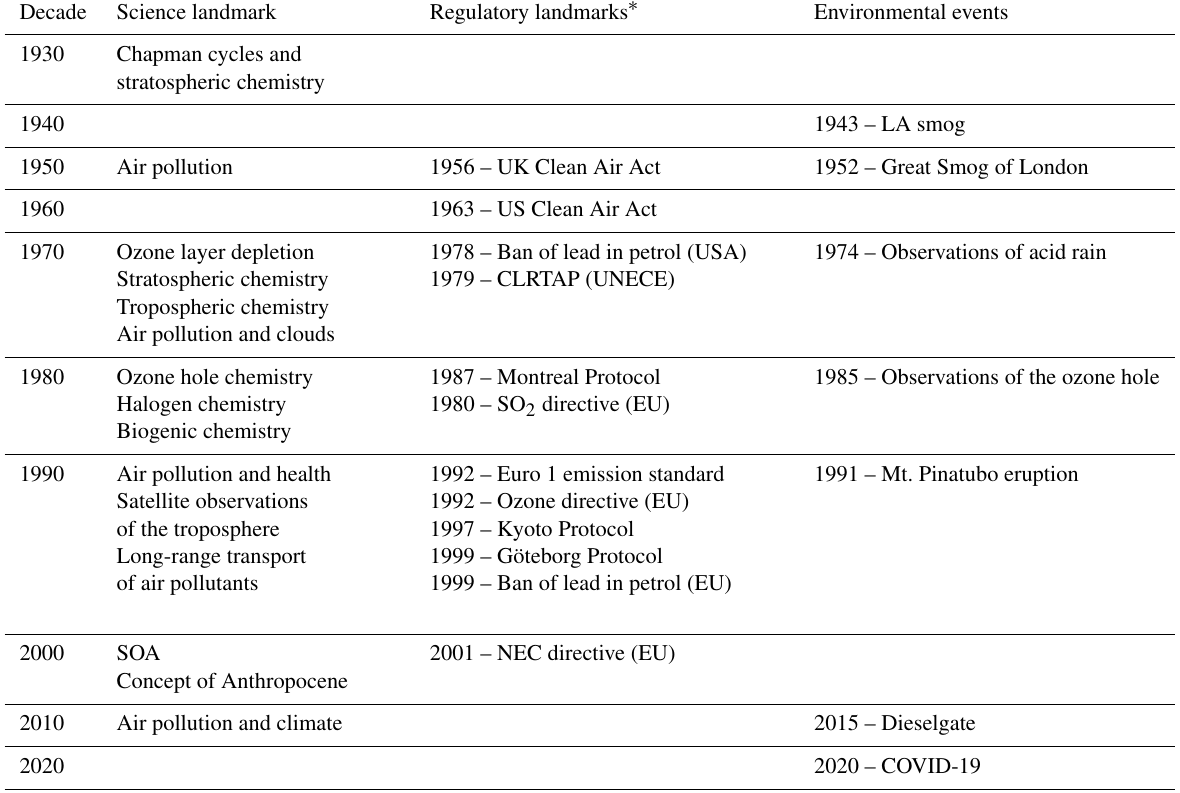
Table 2. Science, regulatory and environmental landmarks of the 20th and early 21st